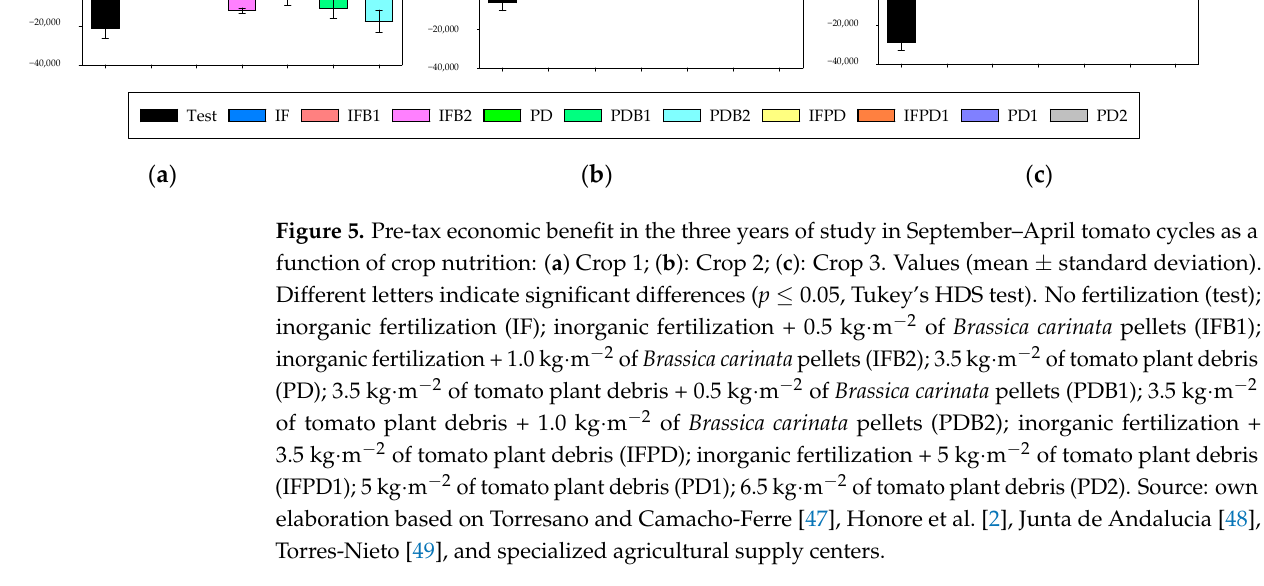
Table 9. Reduction in production costs compared to the conventional production method in the Almeria model.